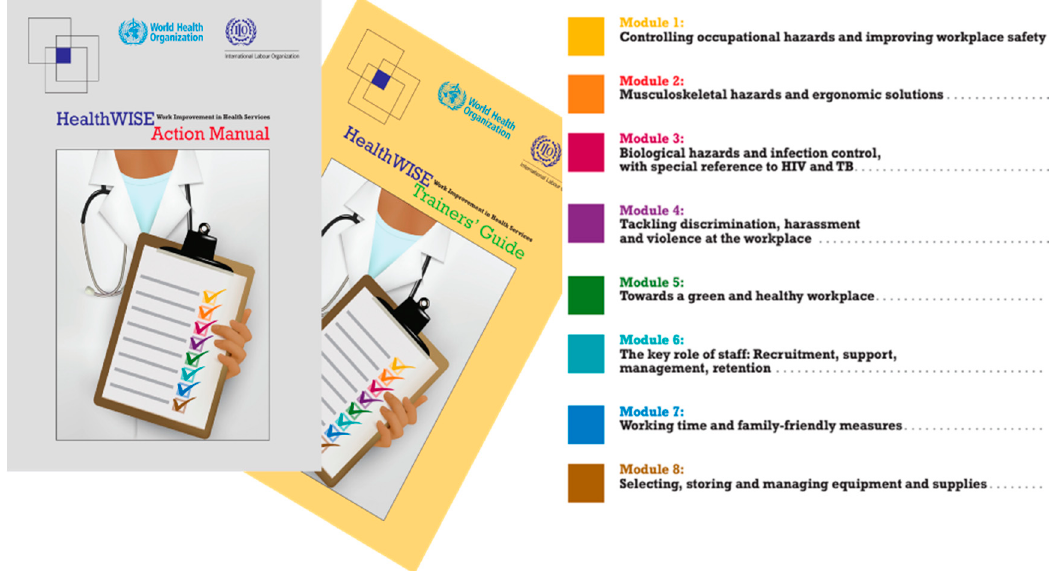
Figure 1. HealthWISE workbooks—the Action Manual and Trainers’ Guide—and a list of the eight modules that cover key areas of occupational health and safety (OHS) for health workers (HWs).